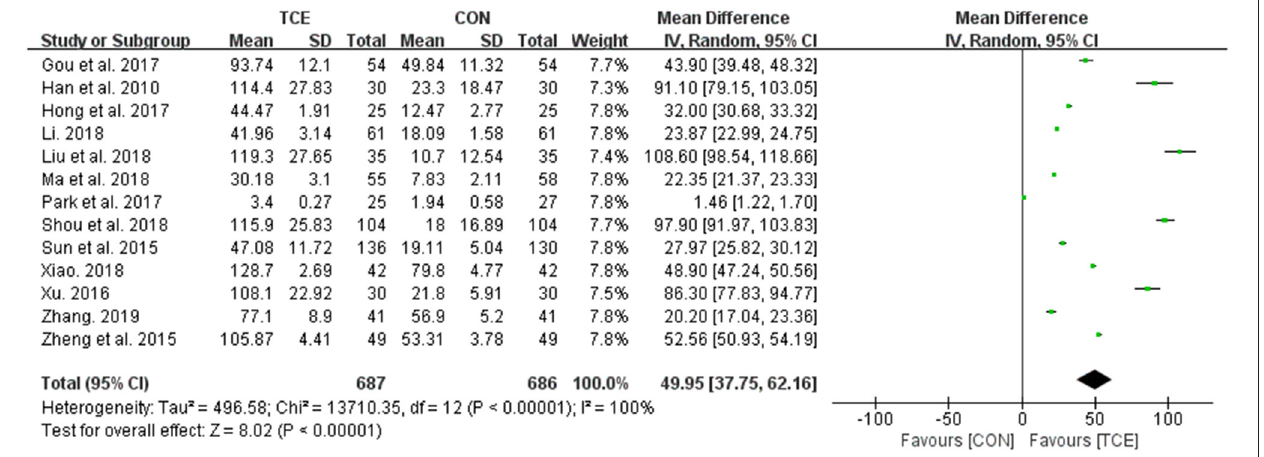
FIGURE 3 | Meta-analysis of the overall effects of TCE on QOL vs. the control intervention. TCE, traditional Chinese exercises; CON, control; SD, standard deviations; CI, confidence intervals; IV, inverse